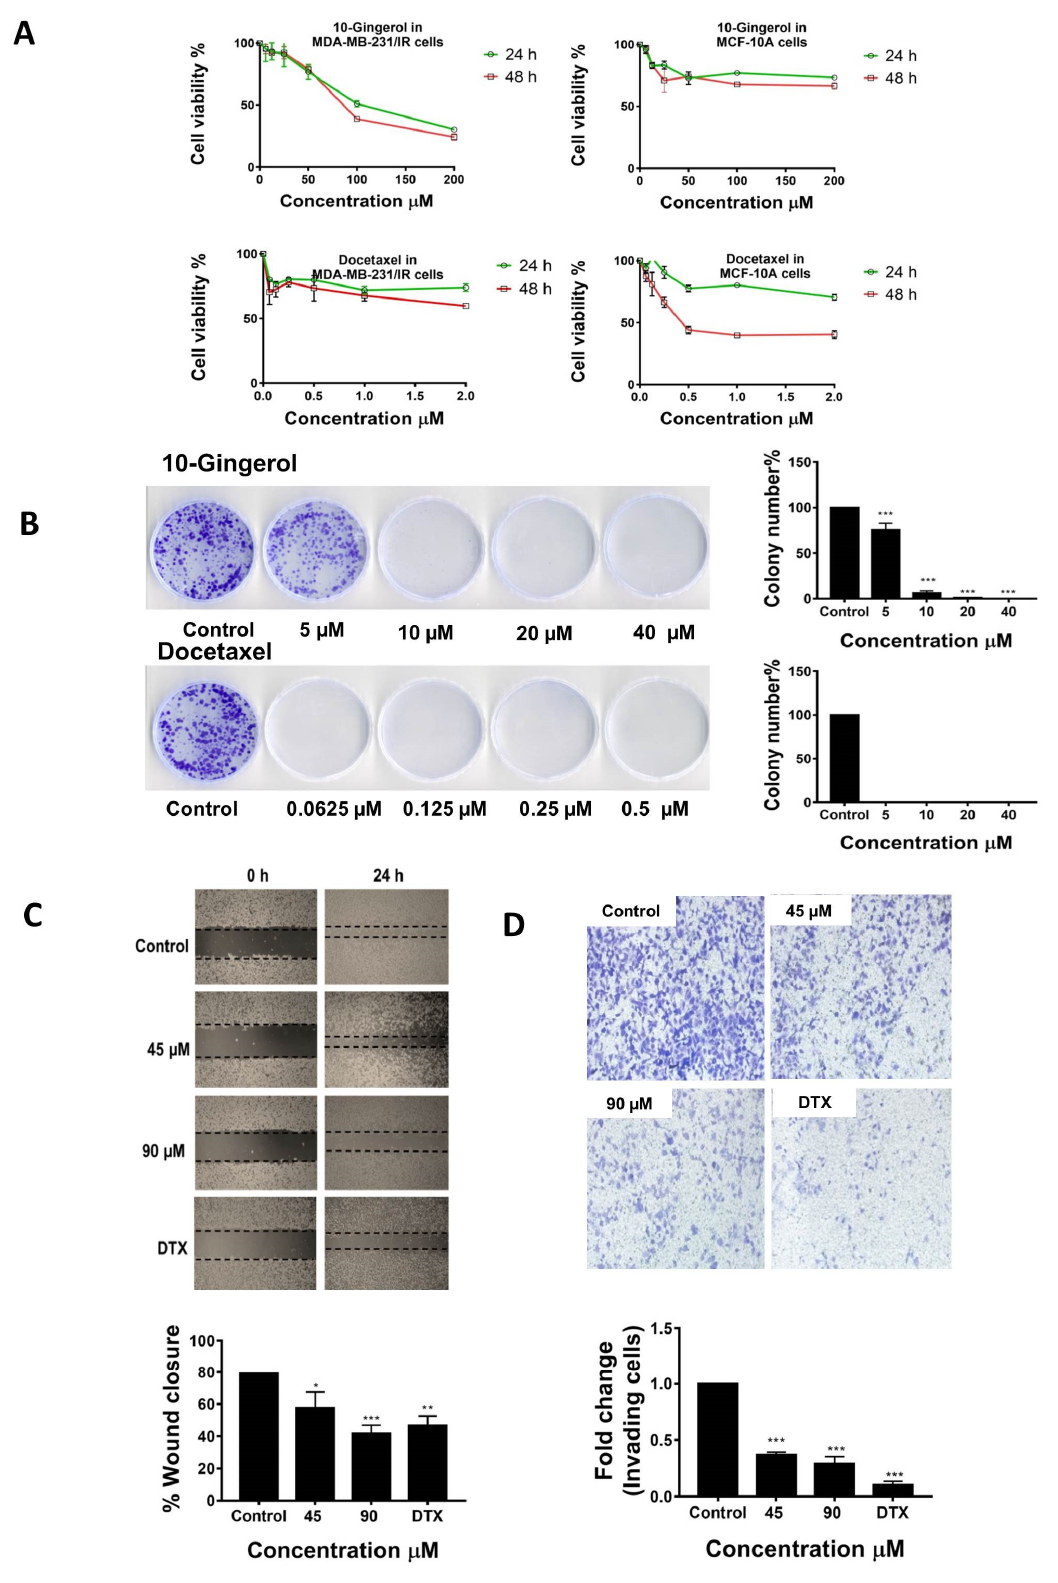
Figure 1. 10-gingerol suppresses the proliferation, migration and invasion of MDA-MB-231 / IR cells: ( A ) Anti-proliferative e ff ects of 10-gingerol and docetaxel (DTX) in MDA-MB-231 / IR and MCF-10A cells. ( B ) E ff ects of 10-gingerol and docetaxel on the clonogenic ability of MDA-MB-231 / IR cells. ( C and D ) 10-gingerol significantly inhibits migration and invasion of MDA-MB-231 / IR cells. DTX-3 µ M of docetaxel. * p < 0.05, ** p < 0.01, and *** p < 0.001 compared with untreated cells.